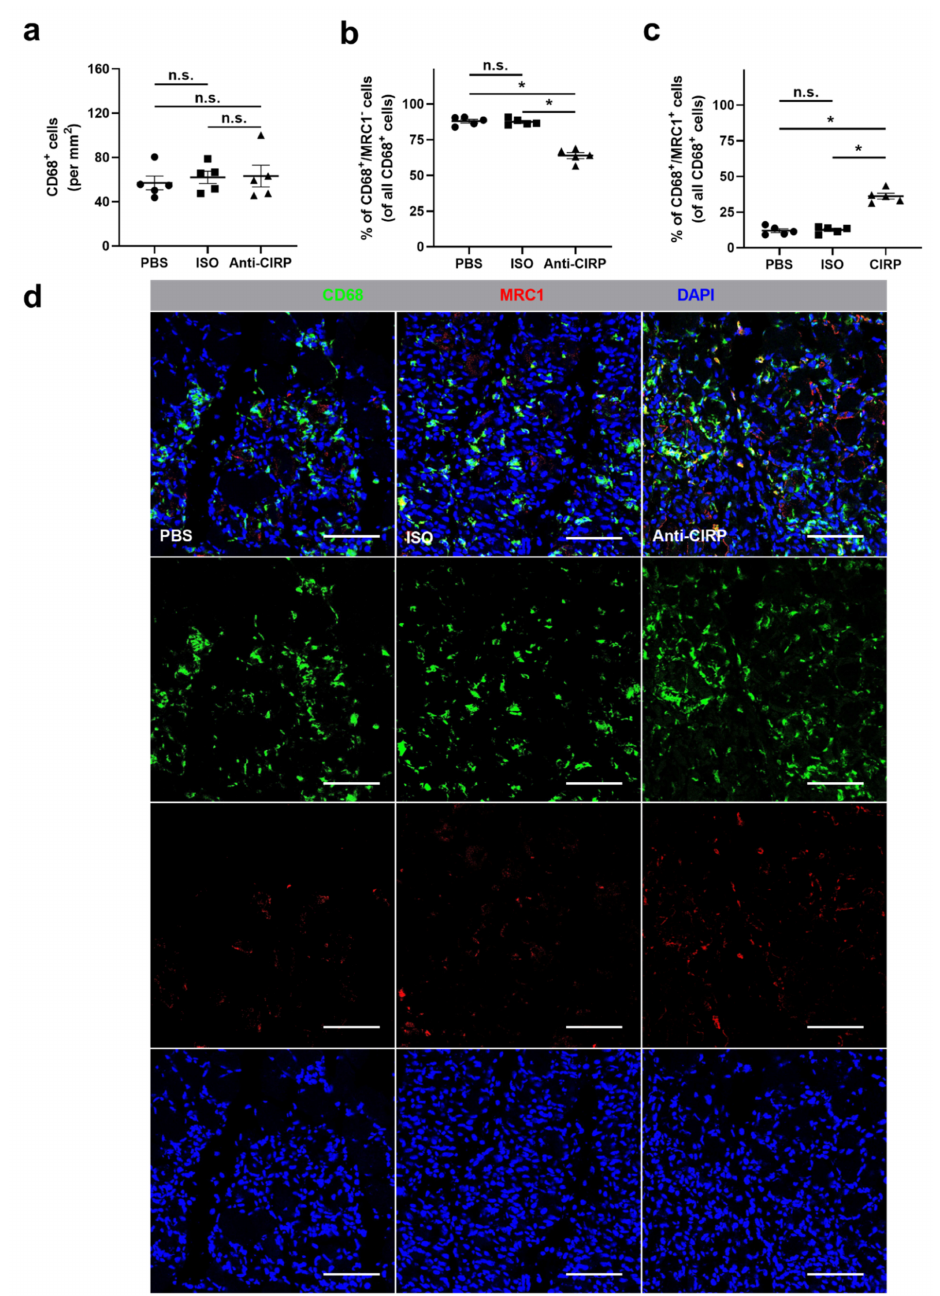
Figure 5. Neutralization of extracellular “Cold-inducible RNA-binding protein” (eCIRP) affects macrophage polarization. The scatter plots display ( a ) the relative amount of CD68 + cells (macrophages) (per mm 2 ), ( b ) CD68 + /MRC1 − (mannose receptor c-type 1) cells (M1-like polarized macrophages), and ( c ) CD68 + /MRC1 + cells (M2-like polarized macrophages) in relation to all CD68 + cells (in percent) in ischemic gastrocnemius muscles of phosphate-buffered saline- (PBS), isotype antibody- (ISO) (both control groups), or anti-CIRP antibody-treated mice (Anti-CIRP) 7 days after femoral artery ligation (FAL). Data are means ± S.E.M., n = 5 per group. n.s. p > 0.05, * p < 0.05 (PBS vs. ISO vs. Anti-CIRP) by one-way ANOVA with the Tukey’s multiple comparisons test, a defined ischemic area (1.5 mm 2 ) of muscle tissue was analyzed per mouse. ( d ) Representative immunofluorescence staining of ischemic gastrocnemius muscle slices of PBS- (left), isotype antibody- (middle), and anti-CIRP-antibody-treated mice (right) 7 days after FAL. Images show single and merged channels of CD68 and MRC1 labeled macrophages (anti-CD68, green; anti-MRC1, red) and nucleic acid (DAPI, blue). Scale bars represent 50 µ